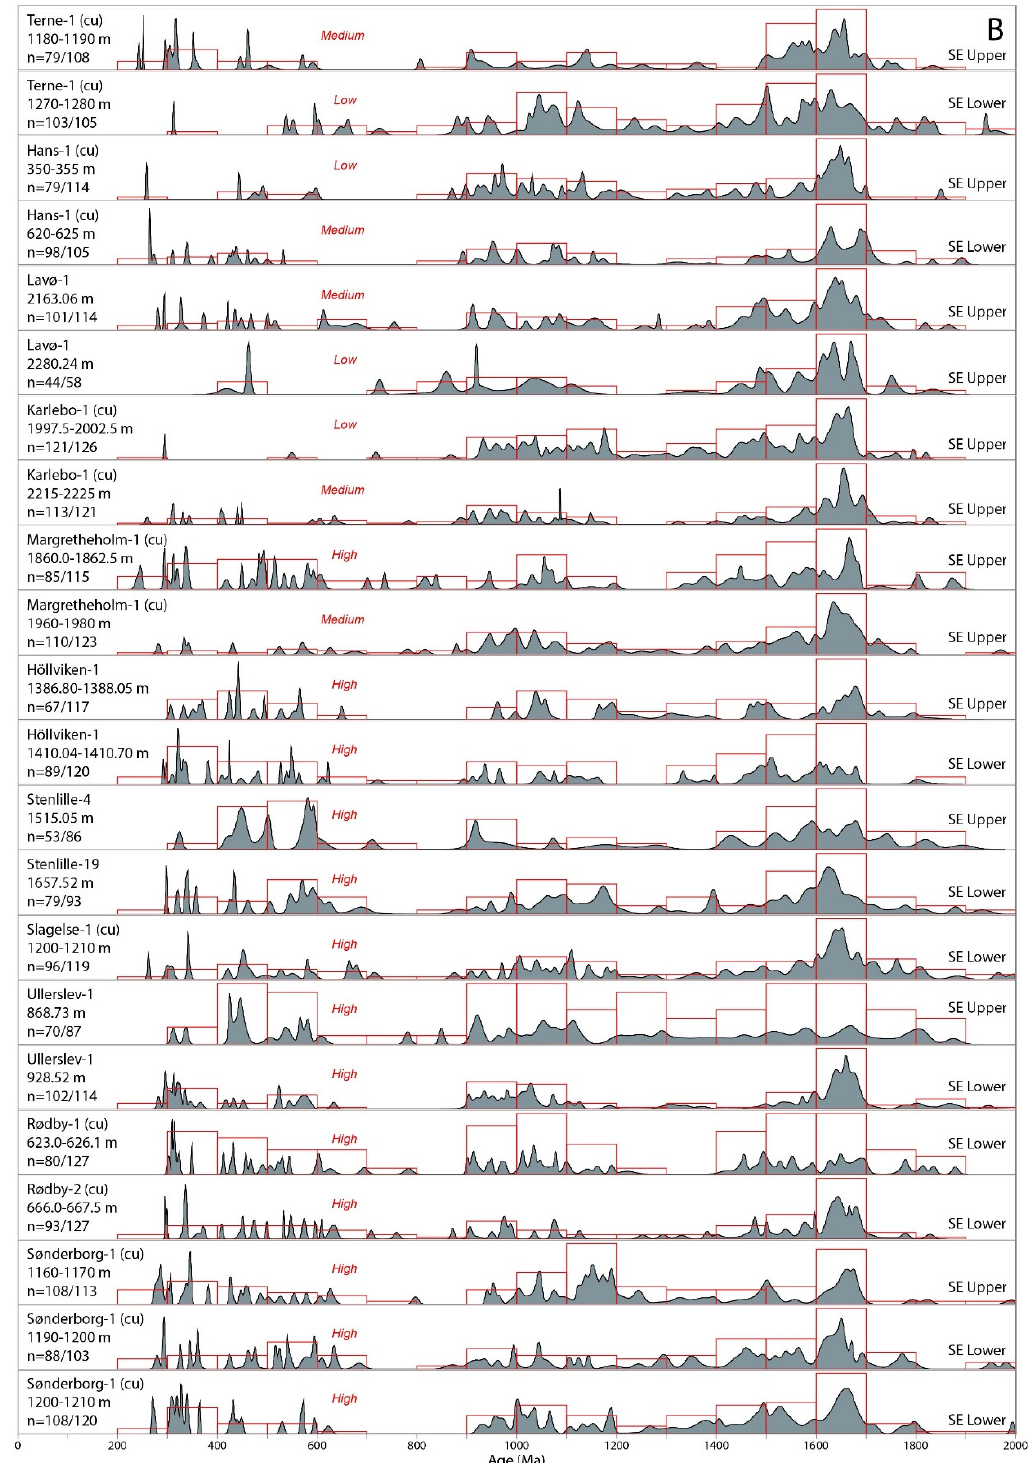
Figure 5. Zircon U-Pb age distributions with 100 Ma histograms for the northwestern ( A ) and southeastern ( B ) parts of the Gassum Formation. The well name, depth and number of concordant zircon age analyses are shown for each sample. Only ages with a discordance < 10% are included, and results with common lead are excluded. A crossover age at 1200 Ma between 206 Pb/ 238 U and 207 Pb/ 206 Pb dates is applied. A qualitative estimate of the relative amount of Variscan ages in the samples is indicated as high/medium/low. Most samples are from cores, whereas some are from cuttings (cu).